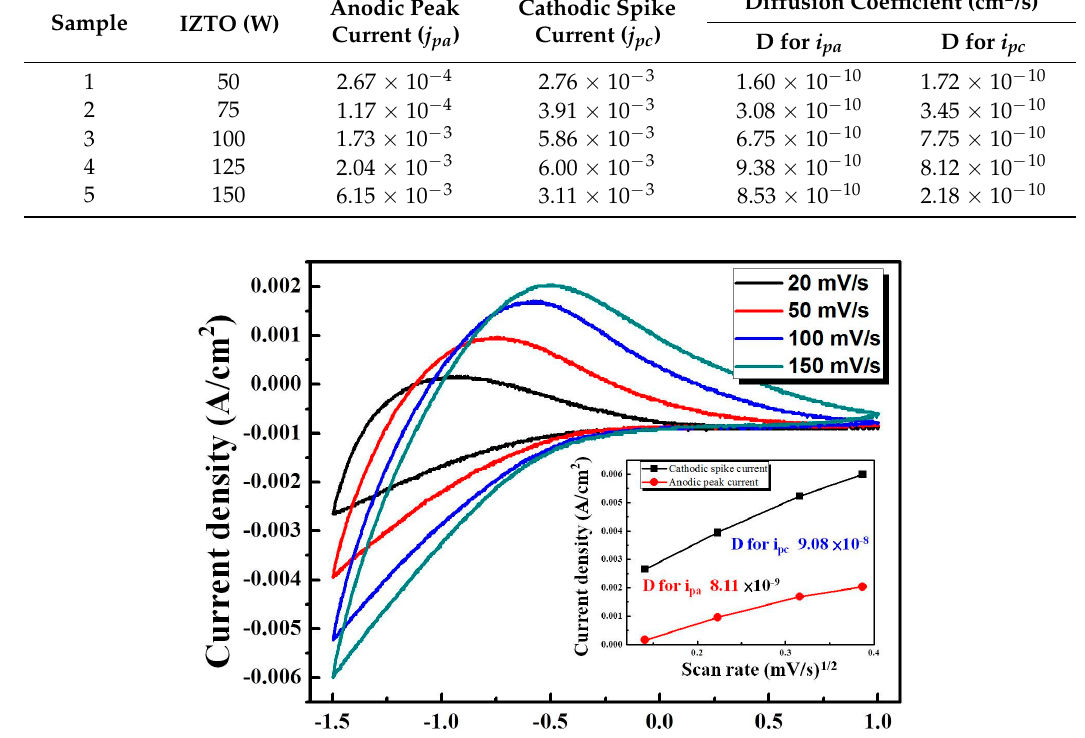
Figure 8. Th e CV curves of the 50th cycle of WO 3 /IZTO films at 125 W for various scan rates ranging from 20 to 150 mVs − 1 .